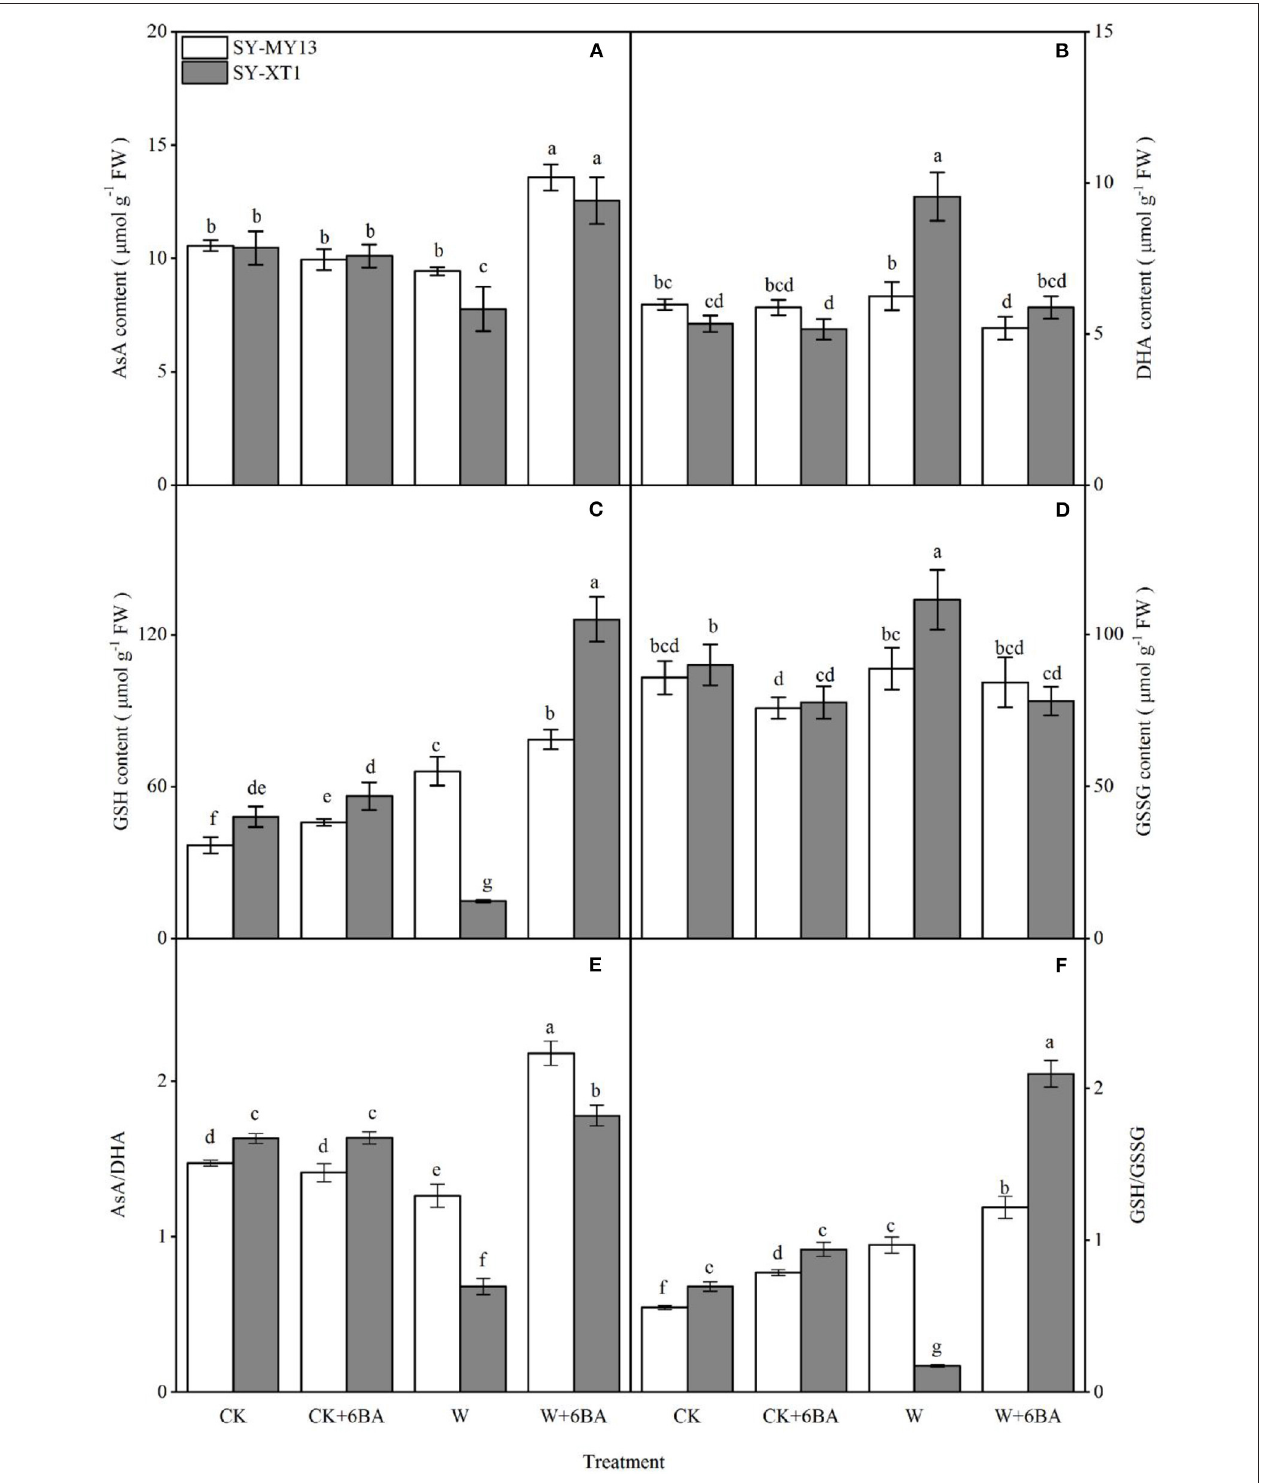
FIGURE 5 | Effects of 6-BA on ascorbic acid (ASA) (A) , dehydroascorbic acid (DHA) (B) , reduced glutathione (GSH) (C) , and oxidized glutathione (GSSG) concentrations (D) and the ratios AsA/DHA (E) and GSH/GSSG (F) in two waxy corn inbred lines in waterlogged conditions. CK, normal watering conditions only; CK + 6-BA, 0.5mM of 6-BA plus normal watering conditions; W, waterlogged; W + 6-BA, addition of 0.5mM of 6-BA plus waterlogging stress conditions. Data represent means ± SD of three replicates. For each variable, means with different lowercase letters were significantly different ( P < 0.05).